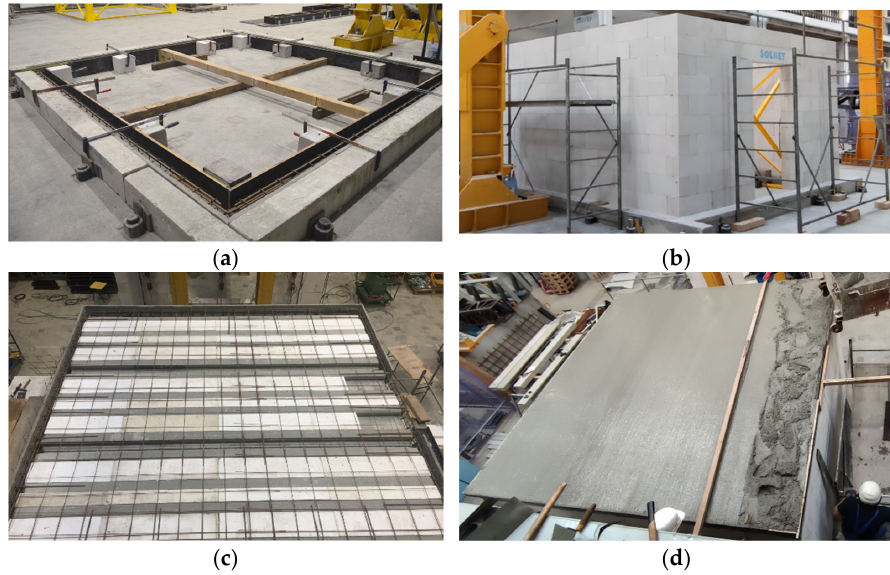
The opening is covered with a prefabricated system lintel made of AAC. The walls were erected with a thin joint without filling the head joints—Figure 2b.